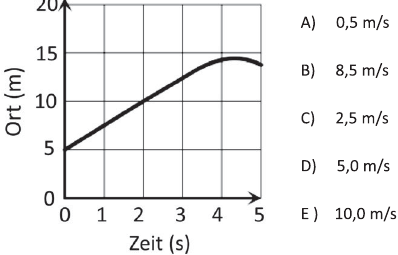
FIG. 1. Example item from the TUG-K. The task has been translated verbatim into German and reads as follows in the English original: The following figure shows the position versus time graph of an object. The velocity of the object at t ¼ 2 s is :. The axis labels are also written in German and mean time ( “ Zeit ” ) and position ( “ Ort ” ).